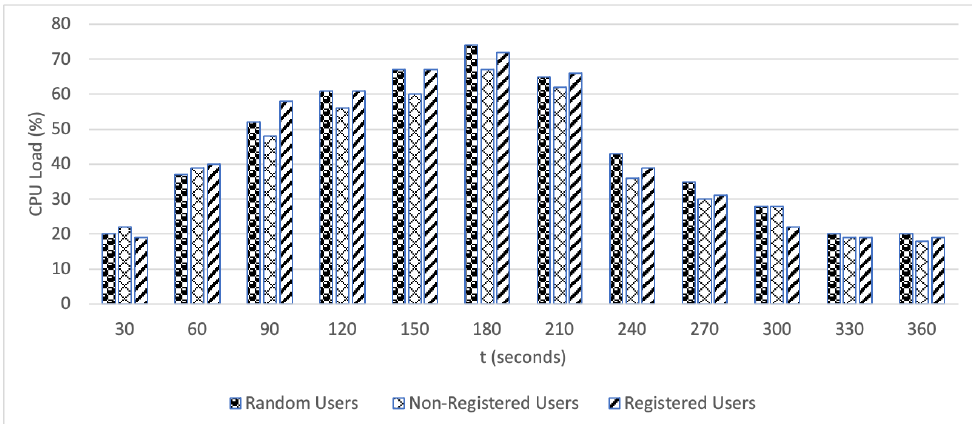
Figure 8. SIP server CPU usage for registered, nonregistered, and random users after the SIP-DRDoS attack while our defense mechanism was active.